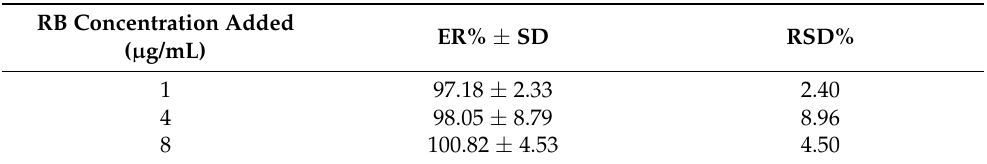
Table 5. Skin extraction recoveries of RB from dermatomed neonatal porcine skin (means ± SD, n =